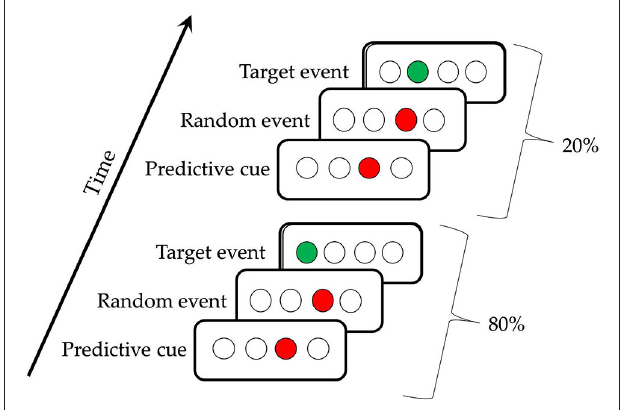
FIGURE 1 | The Triplets Learning Task . The first triplet indicates a High Probability triplet (e.g., 3r1) and the second triplet indicates a Low Probability triplet (e.g., 3r2), for a participant receiving the regularity 1r2r4r3r.